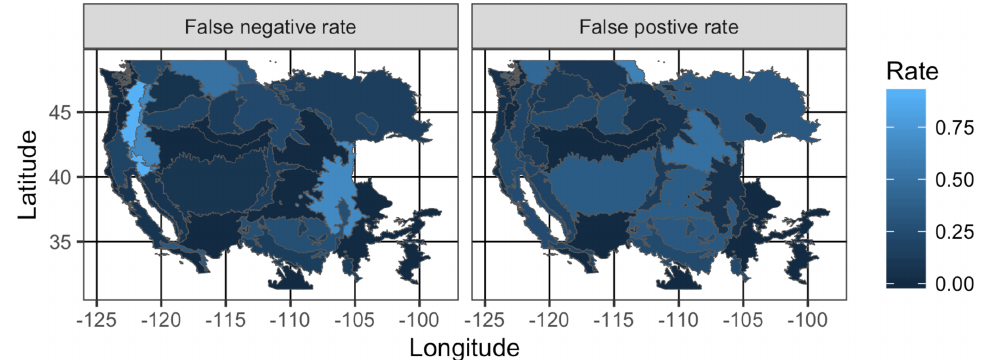
Figure 6. False positive (FP) and false negative (FN) rates of an independent testing dataset of small and large fires from 2015 to 2016, mapped across Environmental Protection Agency (EPA) level III ecoregions. No testing data were available for those ecoregions that are not